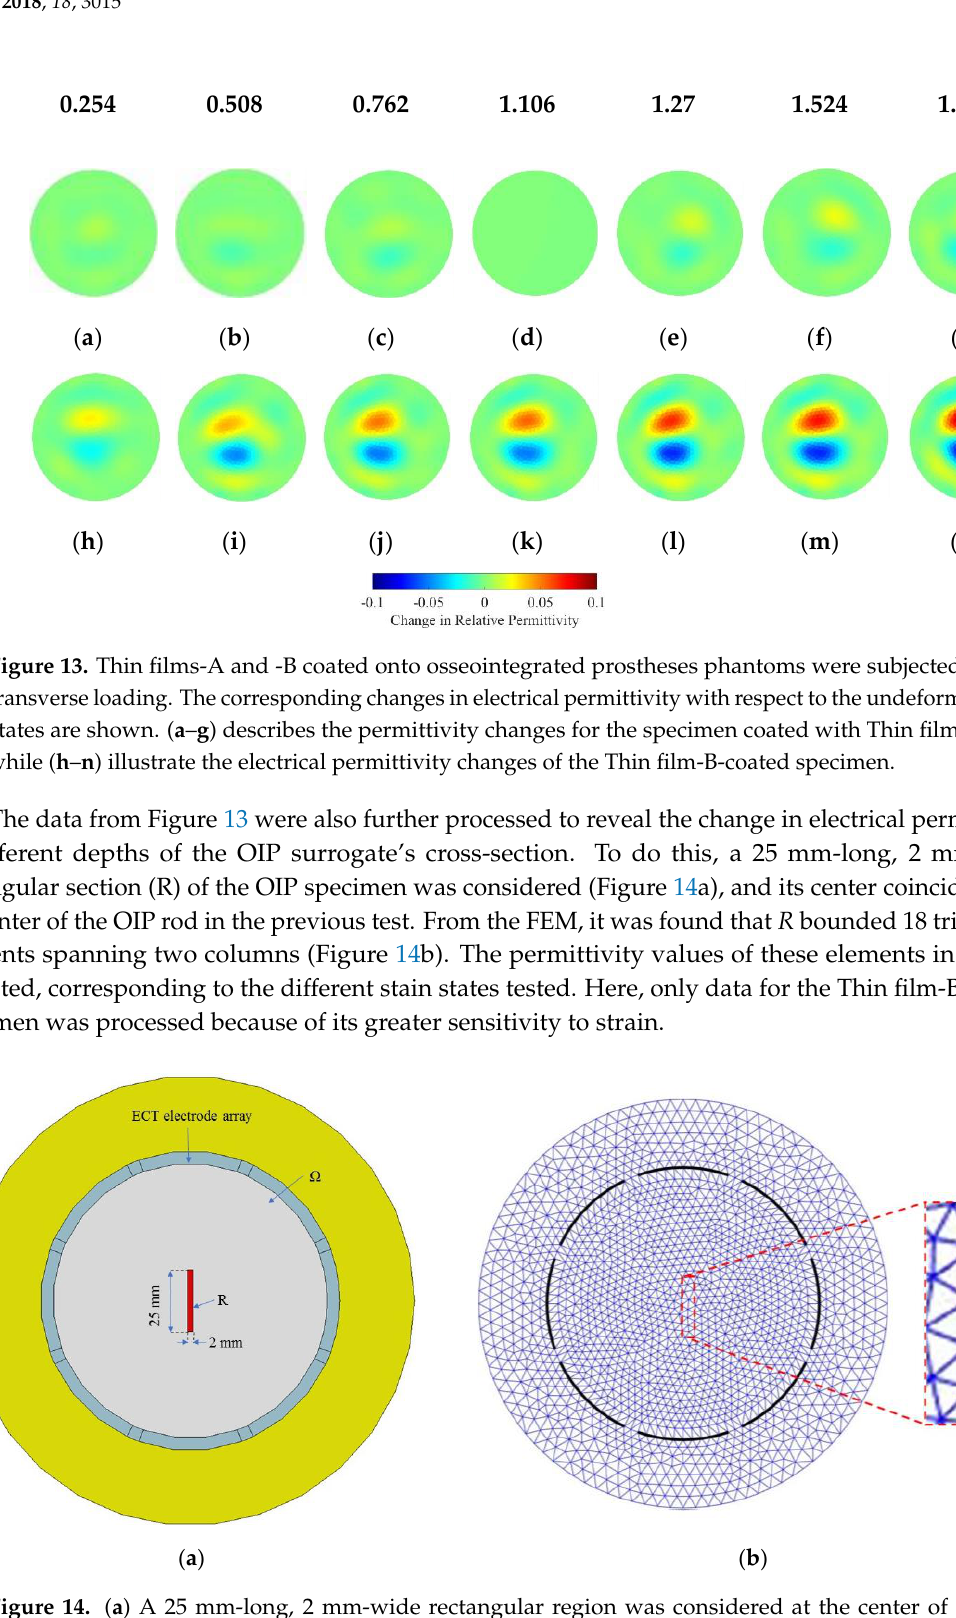
Figure 14. ( a ) A 25 mm-long, 2 mm-wide rectangular region was considered at the center of the sensing region and coincided with a portion of the OIP phantom. ( b ) The rectangular strip consisted of 18 triangular elements. y = 0.254 mm